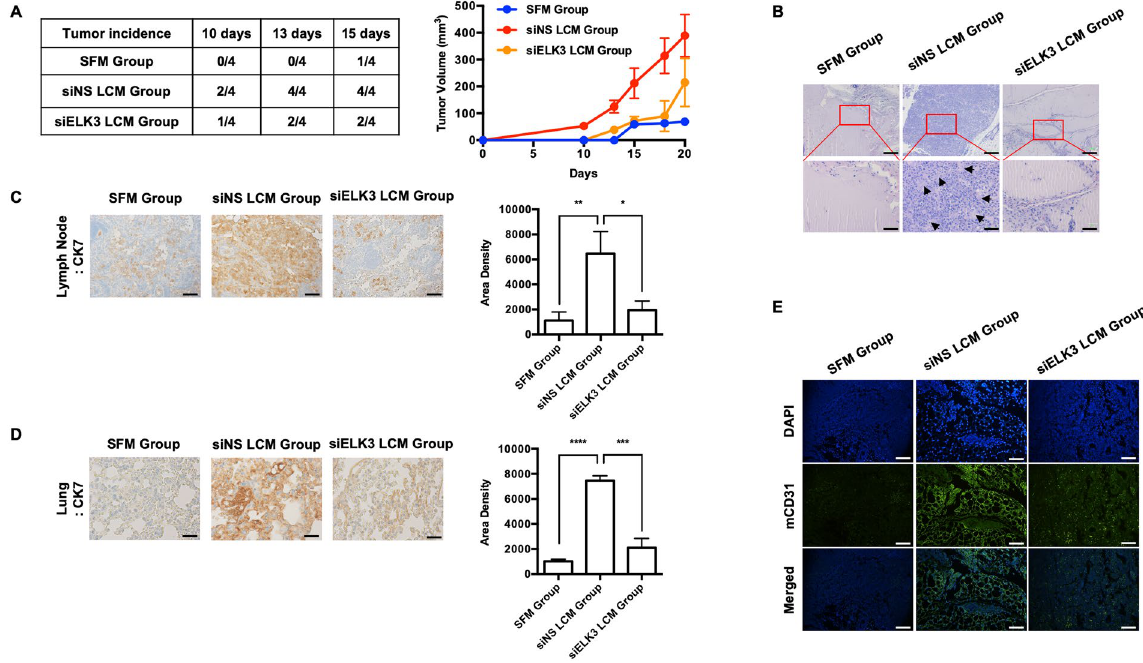
Figure 3. The suppression of ELK3 in LECs diminishes the ability of LECs to promote tumor growth in vivo . Athymic nude mice (female, 5–6 weeks of age, 18–20 g) were pretreated with LCM harvested from siNS- or siELK3-transfected LECs or SFM subcutaneously for 2 weeks, as described in the Material and Methods. Then, 2 × 10 6 MBA-MB-231 cells were mixed with 3.7 × 10 6 siNS- or siELK3-transfected LECs and Matrigel and inoculated into the mammary fat pads of the corresponding nude mice. MDA-MB-231 cells with siNS LECs were inoculated into siNS LCM-pretreated mice (siNS LCM group), and MDA-MB-231 cells with siELK3 LECs were inoculated into siELK3 LCM-pretreated mice (siELK3 LCM group). For the control, 2 × 10 6 MDA-MB-231 cells were inoculated into SFM-pretreated mice (SFM group). ( A ) Tumor incidence was examined in four mice from each group on the indicated days after inoculation (Left). Tumor size was measured at the indicated date after inoculation and presented as a graph (Right). ( B ) Matrigel plugs excised from mice 20 days after inoculation were fixed and stained with H&E. Scale bar represents 50 μ m. LNs ( C ) or lungs ( D ) were isolated from mice from each group, and immunohistochemical staining was performed to detect human cytokeratin-7 (CK7). Scale bar represents 50 μ m. ( E ) LNs from each group were analyzed for the expression of mouse CD31 by immunofluorescence staining. Scale bar represents 50 μ m. Error bars represent the standard error from three independent experiments, and each experiment was performed using triplicate samples. * P < 0.05, ** P < 0.01 *** P < 0.001 and **** P < 0.0001 (Student’s